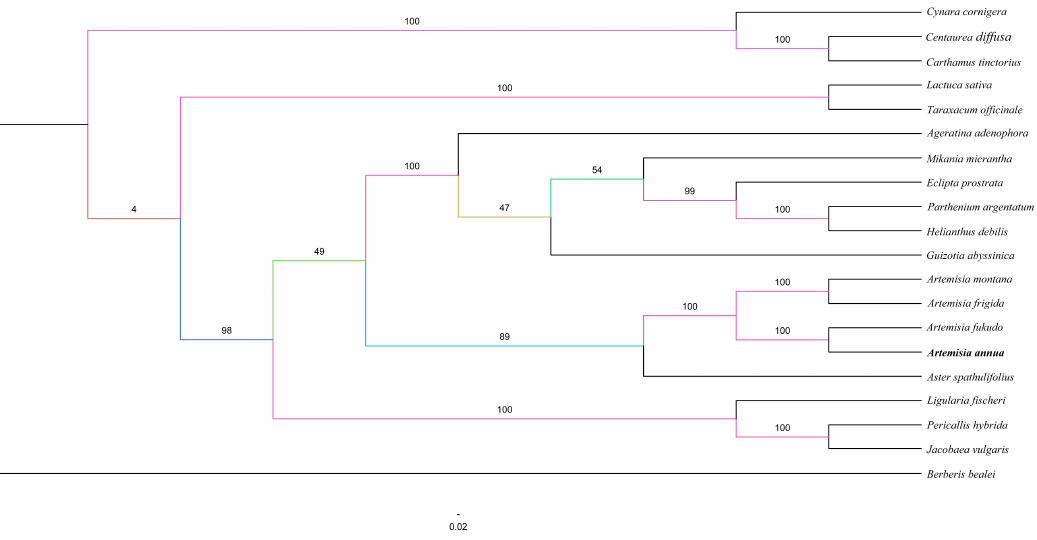
Figure 4. ML phylogenetic tree reconstruction 20 taxa of Asteraceae clade based on concatenated sequence from 50 chloroplast protein-coding genes. The position of Artemisia annua is indicated in block letter. Berberis bealei was set as the outgroup.